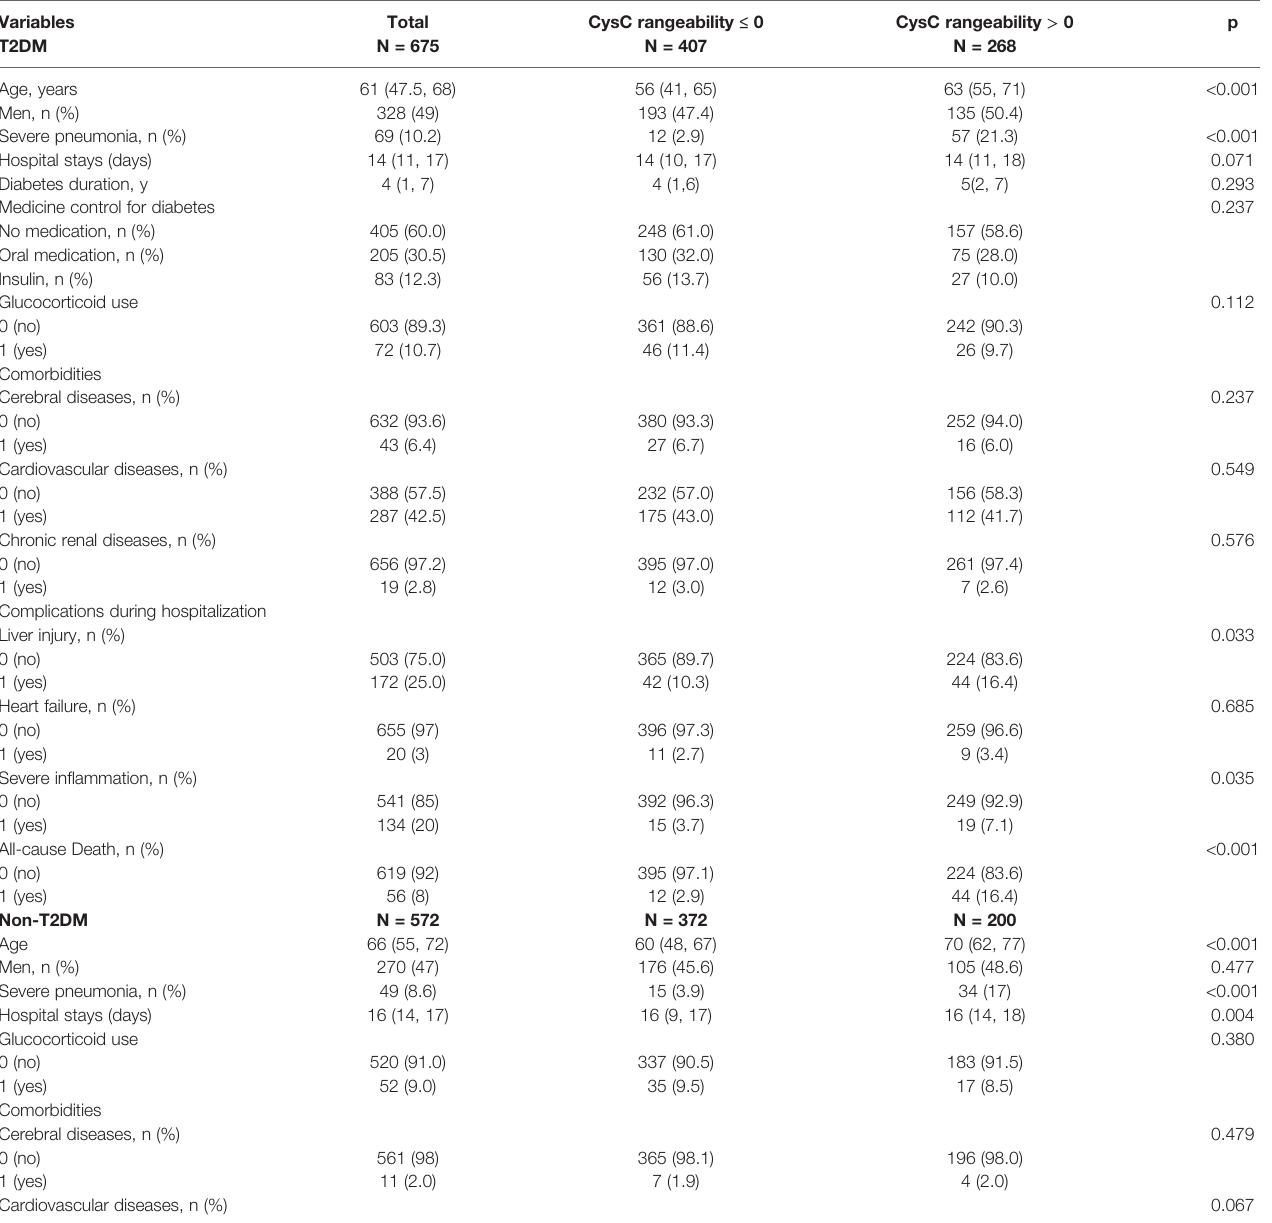
TABLE 3 | Characteristics of T2DM patients and non-T2DM patients grouped by CysC